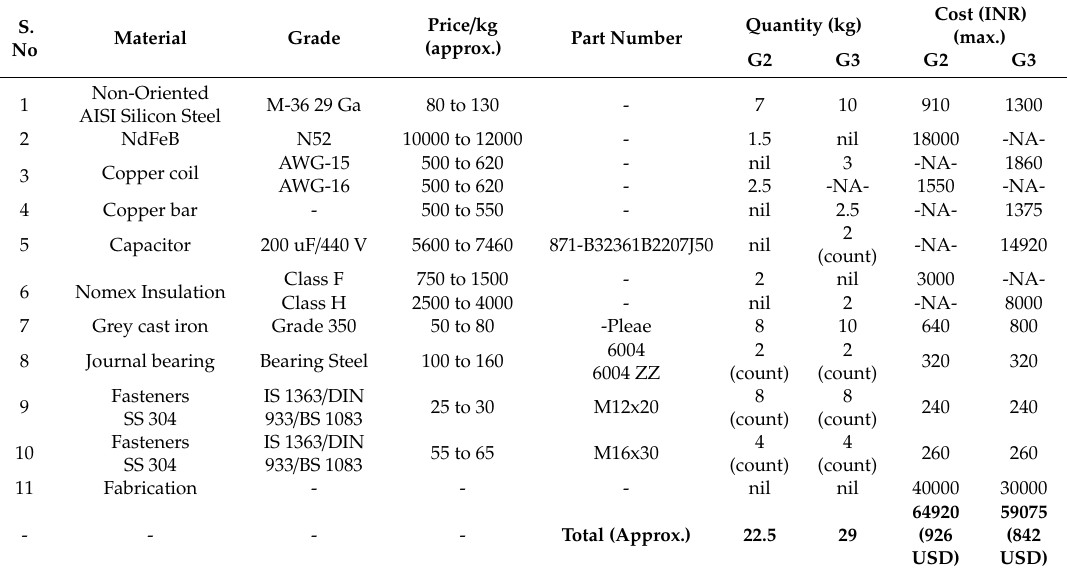
Table 6. Overall cost analysis of PMA-SynRG and